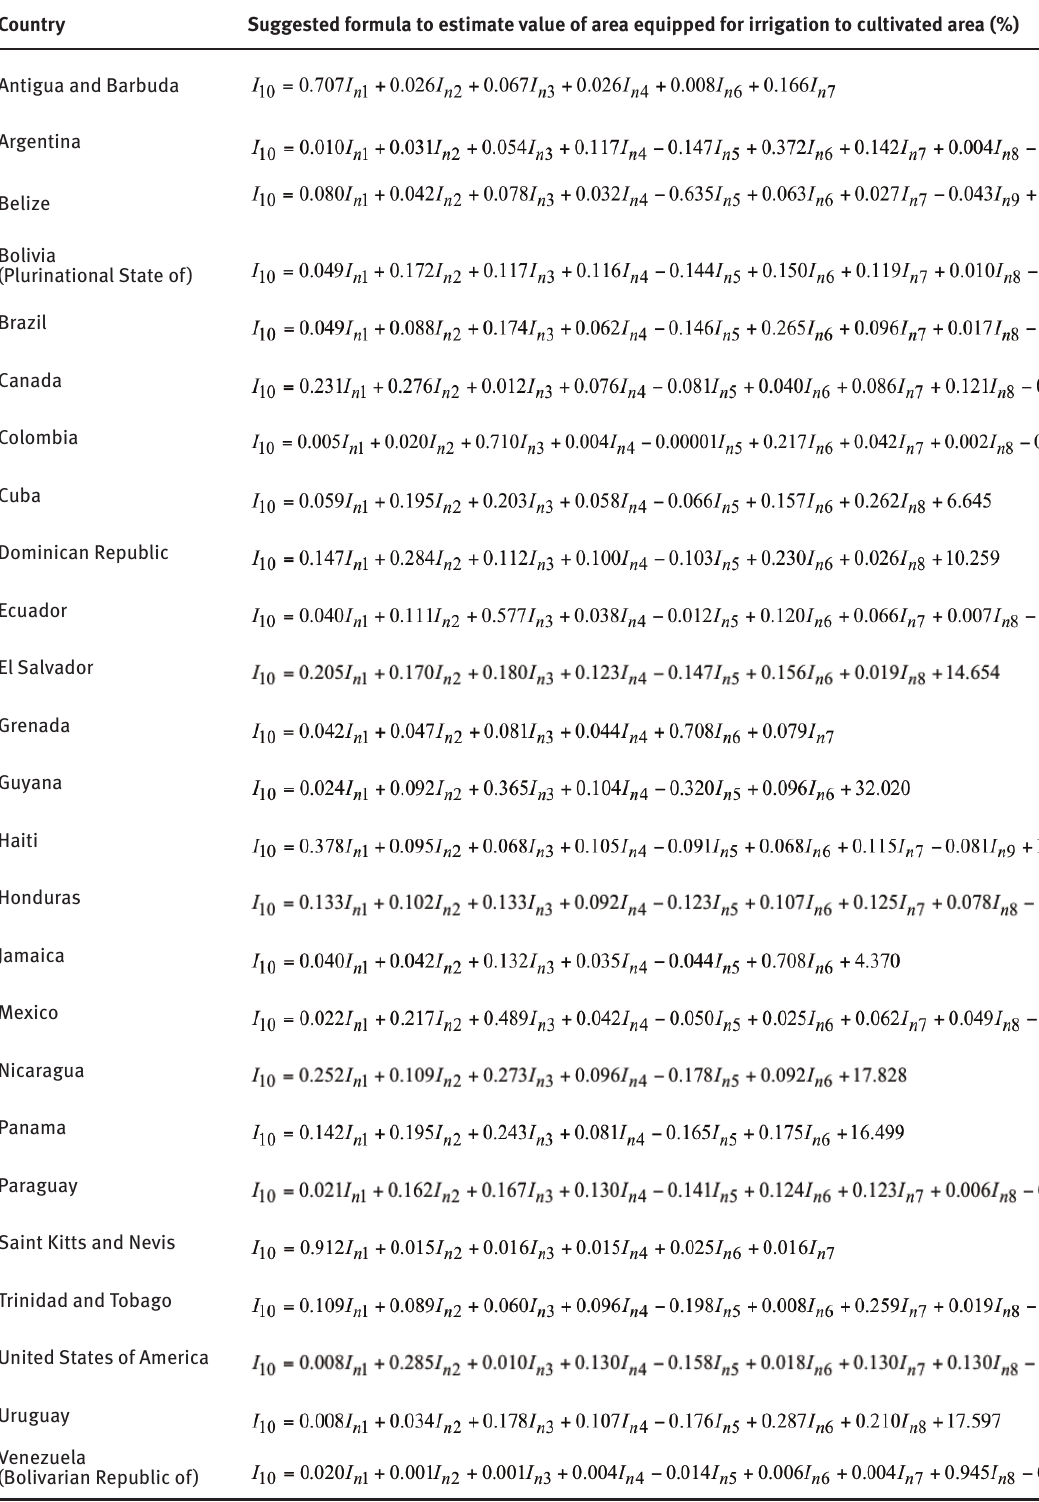
Table 1: Estimated functions using the first method (Eq. 9) for value of area equipped for irrigation to cultivated area in Americas (25 coun- tries), this function is not calculable for Bahamas, Barbados, Chile, Costa Rica, Dominica, Guatemala, Peru, Puerto Rico, Saint Lucia, Saint Vincent and the Grenadines, and Suriname due to very poor irrigation or lack of adequate data